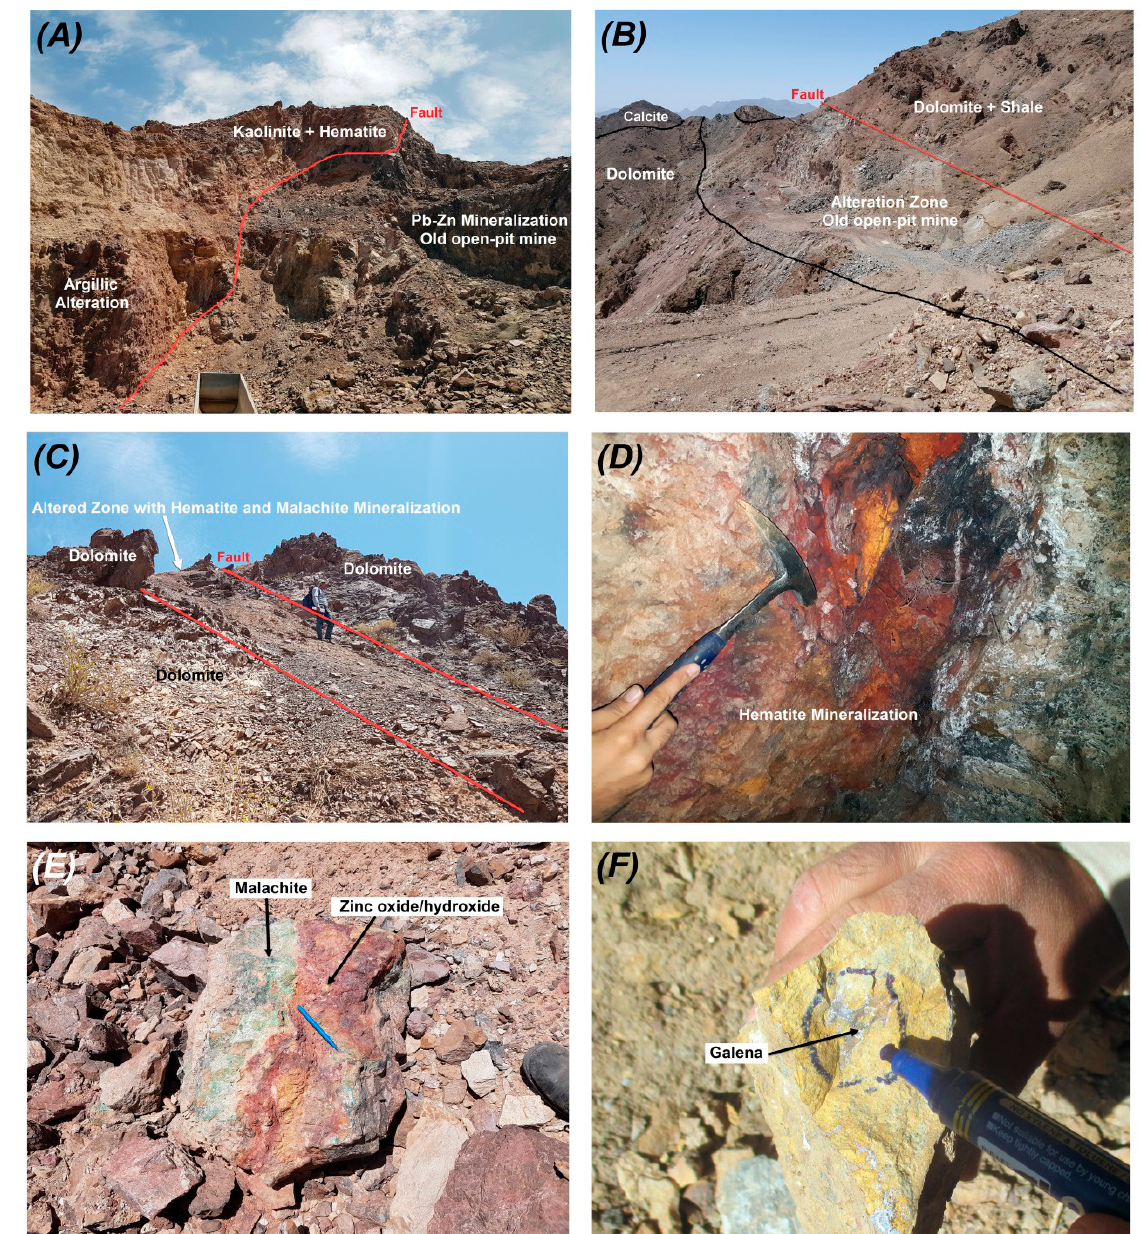
Figure 14. Field photographs of the alteration zones associated with Pb-Zn mineralization in the study area. (A) View old open-pit quarry located in the PE r and E1 lithological units; (B) view of old open-pit quarry located in the PE r , PE ED and E1 lithological units; (C) view of ore mineralization associated with fault contact in the PE r unit; (D) view of the hematite mineralization filling fault contact in the C 1d unit; (E) view of surface occurrence of malachite and zinc oxide/hydroxides in the PE r unit; (F) view of galena mineralization in the dolomitic background in the C 1d unit.